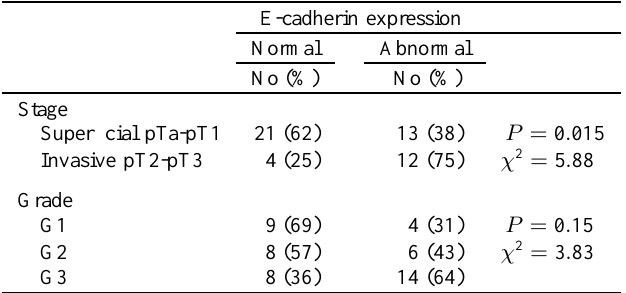
Table 3 Relationships of E-cadherin expression to histopathological